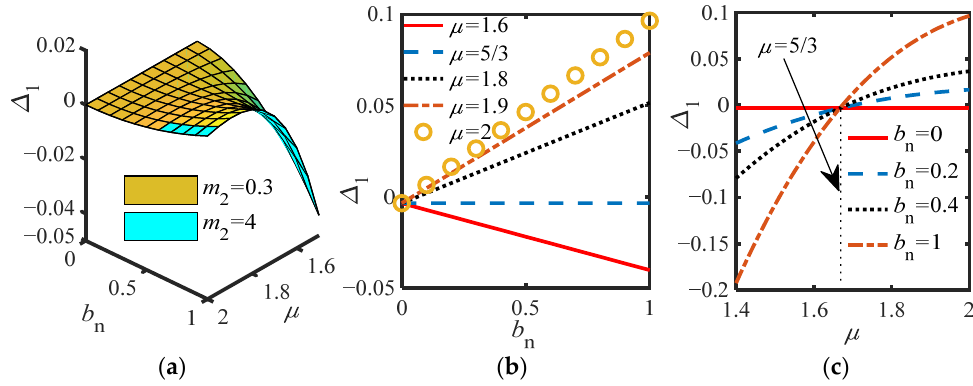
Figure 5. ( a ) Δ 1 vs. μ and b n for different m 2 ; ( b ) Δ 1 vs. b n for different μ ( m 2 = 0.3, c s = 0.003, c n = 0.002); Figure 5. ( a ) ∆ 1 vs. µ and b n for different m 2 ; ( b ) ∆ 1 vs. b n for different µ ( m 2 = 0.3, c s = 0.003, ( c ) Δ 1 vs. μ for different b n ( m 2 = 0.3, c s = 0.003, c n = 0.002). c n = 0.002); ( c ) ∆ 1 vs. µ for different b n ( m 2 = 0.3, c s = 0.003, c n = 0.002).